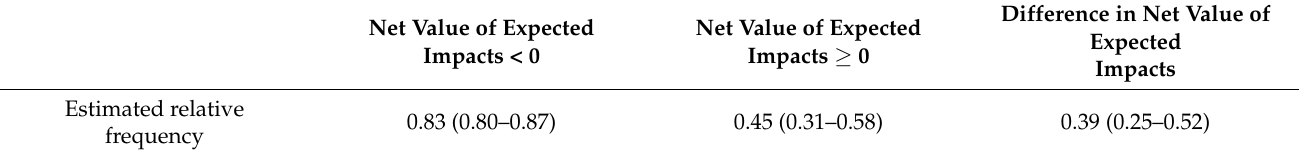
Table 3. Estimated relative frequency of decision-making favouring mitigation of climate change by the valence of the net value of expected impacts of climate change and 90%